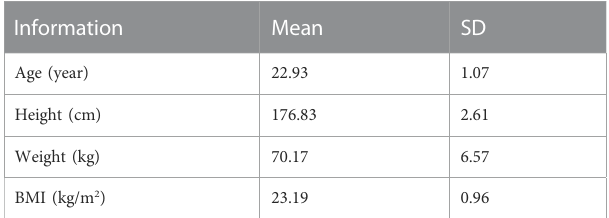
TABLE 1 Descriptive characteristics of 14 participants.